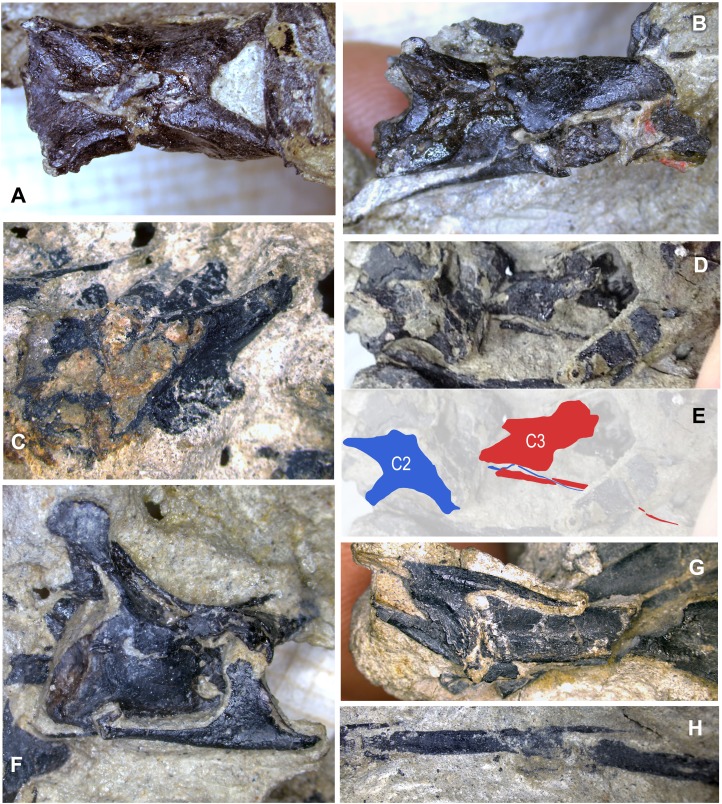
Select axial elements of WYDICE-DML-001.Cervical vertebra three in dorsal (A) and right lateral (B) views. (C) Mid-cervical vertebra in cross-section. Photo and schematic of association between axis and cervical three (D and E). (F) Cervicodorsal in right lateral view. Articulated middle (G) and distal (H) caudal vertebrae in right lateral views.